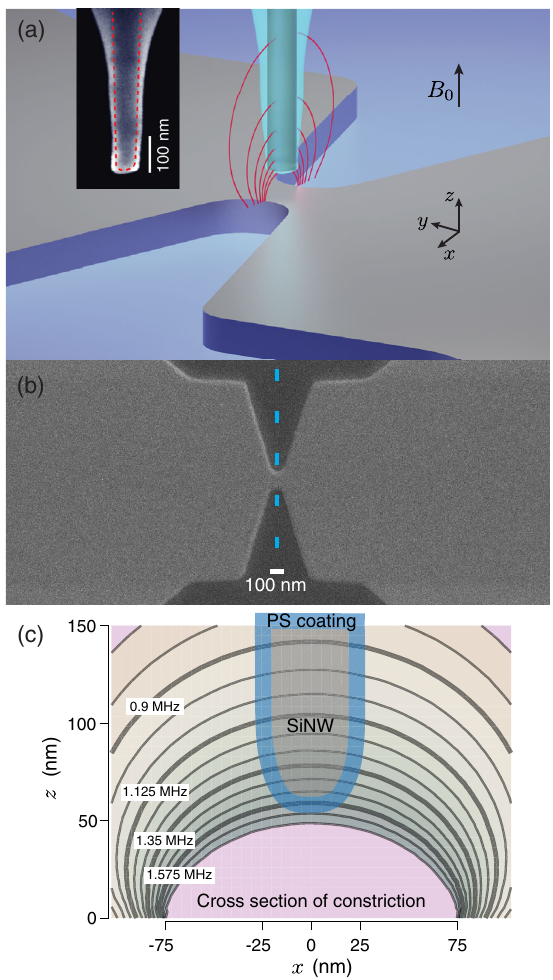
FIG. 1. (a) Schematic rendering of the experimental appa- ratus, showing the polystyrene-coated nanowire, the CFFGS, and the static field B 0 used for the magnetic resonance experiments. The lines near the constriction, shown in red, represent contours of constant Rabi frequency [ ω 1 / ð 2 π Þ ] generated by flowing rf current through the CFFGS at the Larmor frequency. (Inset) SEM of a representative SiNW tip coated with polystyrene. The outline of the SiNW is shown by the dashed line. (b) SEM of the CFFGS. (c) Schematic of polystyrene-coated nanowire and calculated proton Rabi fre- quency as a function of x and z positions relative to the center of the constriction [dashed line in (b)]. The Rabi ⃗ r Þ / ð 2 π Þ , where frequencies are given by ω 1 ð ⃗ r Þ / ð 2 π Þ ¼ γ p B ffiffiffiffiffiffiffiffiffiffiffiffiffiffiffiffiffiffiffiffiffiffiffiffiffiffiffiffi 1 ð /2 is the amplitude of the circularly polarized rf field. Field values were calculated for 50-mA-pk rf current flowing through the